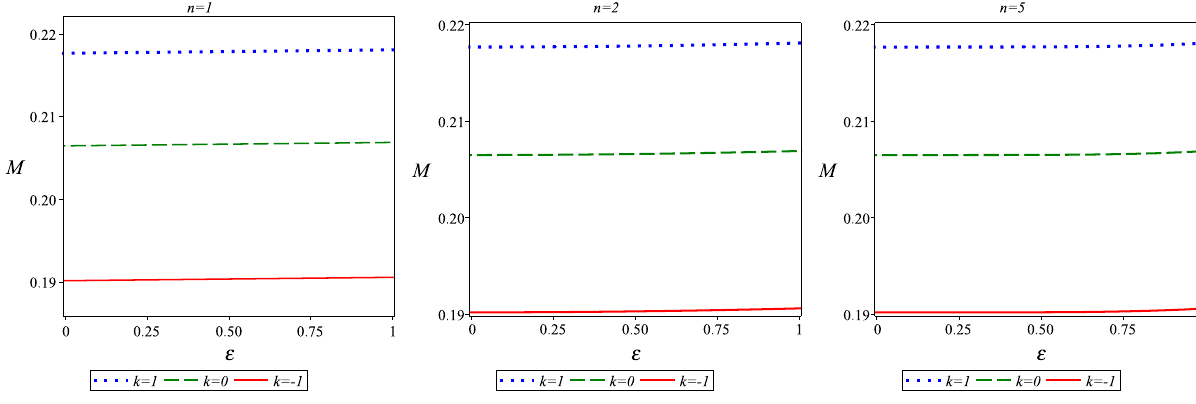
Fig. 4 The first model mass (Eq. (3.8)) in terms of ε for η = 0 . 001, and unit value for other